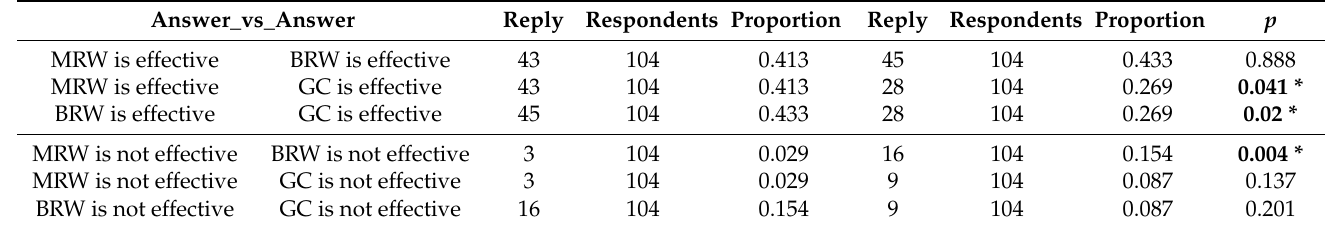
Table 4. Effectiveness of different wires in preventing unwanted tooth displacement according to the respondents.